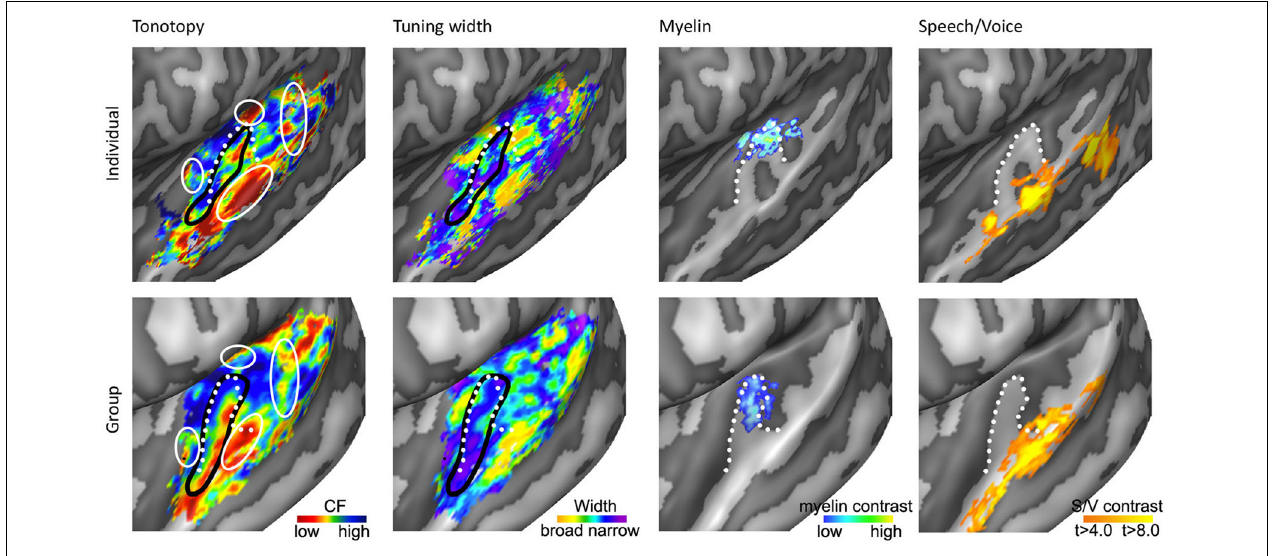
FIGURE 4 | Anatomical and functional characterization of human auditory cortex. The four columns show tonotopy, tuning width, myelin contrast, and speech/voice selectivity in the left hemisphere of a single subject ( top ) and as group results ( bottom ; adapted from Moerel et al., 2013;